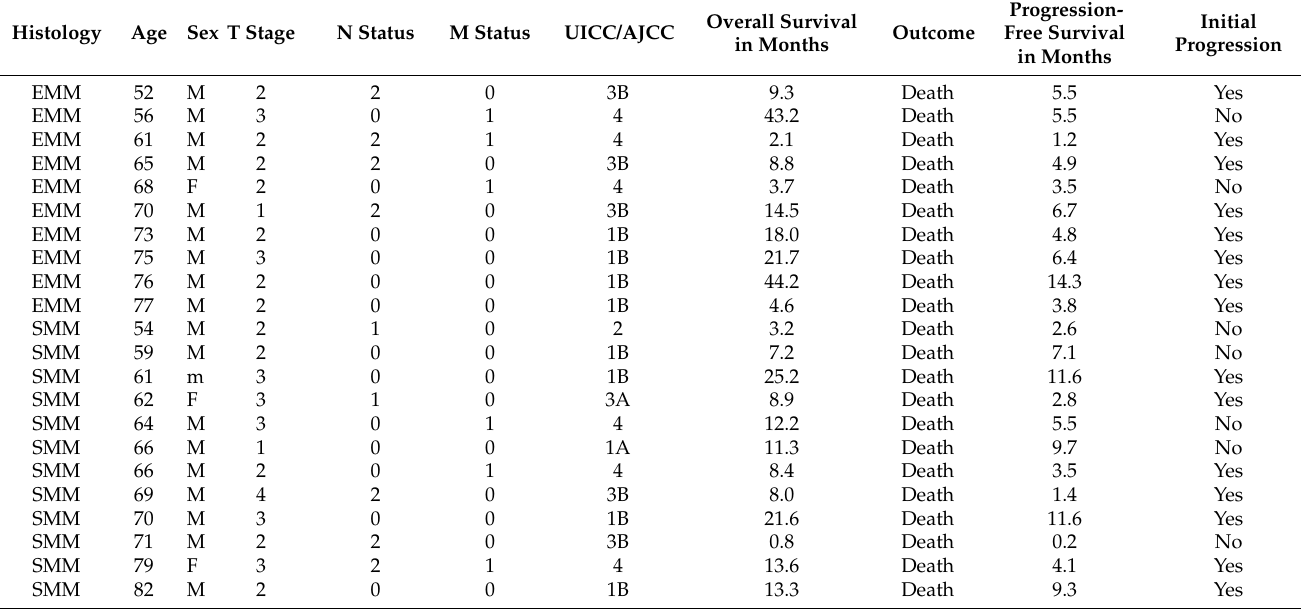
Table 1. Clinicopathological data of the study